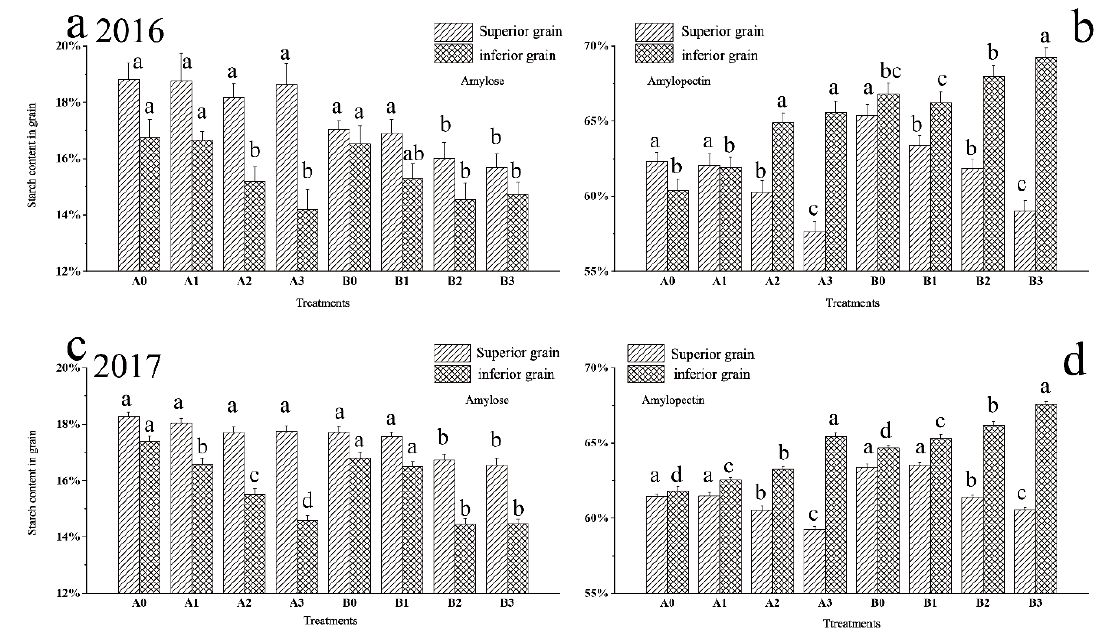
Figure 3. Effects of drought stress at the jointing–booting stage on starch components in superior and inferior grains in growth period overlapping rice in 2016 ( a , b ) and 2017 ( c , d ). Vertical bars represent standard deviation. Values for the same grain type and the same varieties followed by different letters are significantly different at p = 0.05. A0 and B0, control treatments (0 kPa) of SJ6 and DN425; A1 and B1, mild drought stress treatments ( − 10 kPa); A2 and B2, mild drought stress treatments ( − 25 kPa); A3 and B3, severe drought stress ( − 40 kPa).